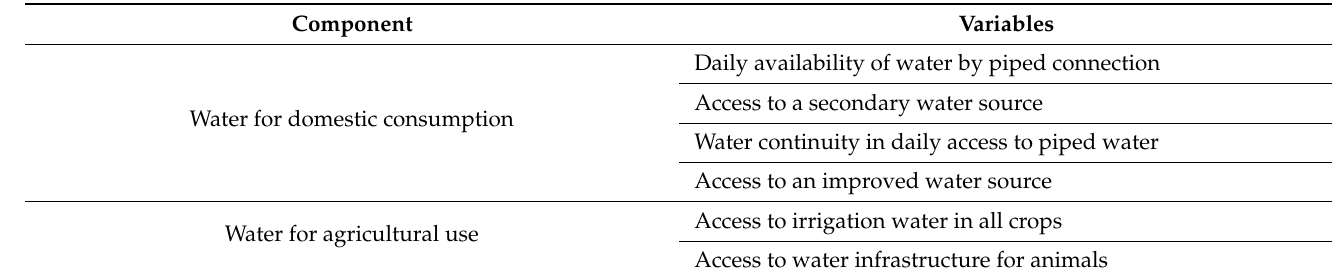
Table 3. Water Index for rural communities of the Tupiza river